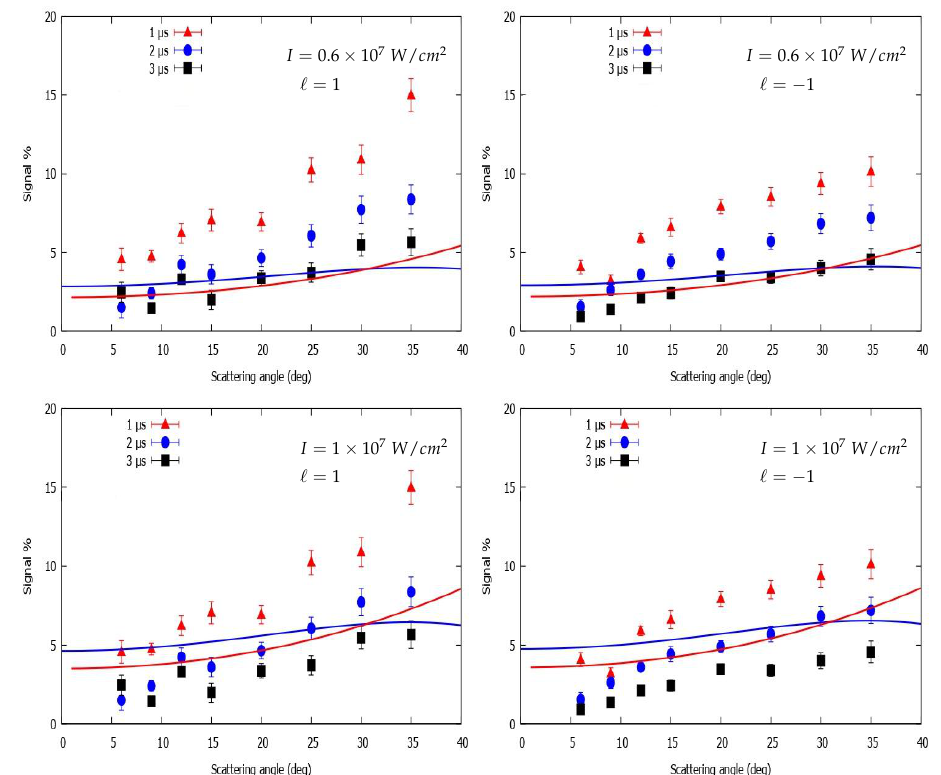
Figure 1. Signal (%) as a function of the scattering angle. The laser intensities are 0.6 × 10 7 W/cm 2 ( upper panels ) and 1 × 10 7 W/cm 2 ( lower panels ). The left figure corresponds to the absorption of one photon ( (cid:96) = 1 ) , while the right figure corresponds to the emission of one photon ( (cid:96) = − 1). The points correspond to the experimental results. The solid red lines correspond to the Kroll–Watson approximation results. The solid blue lines correspond to the second-order Born approximation